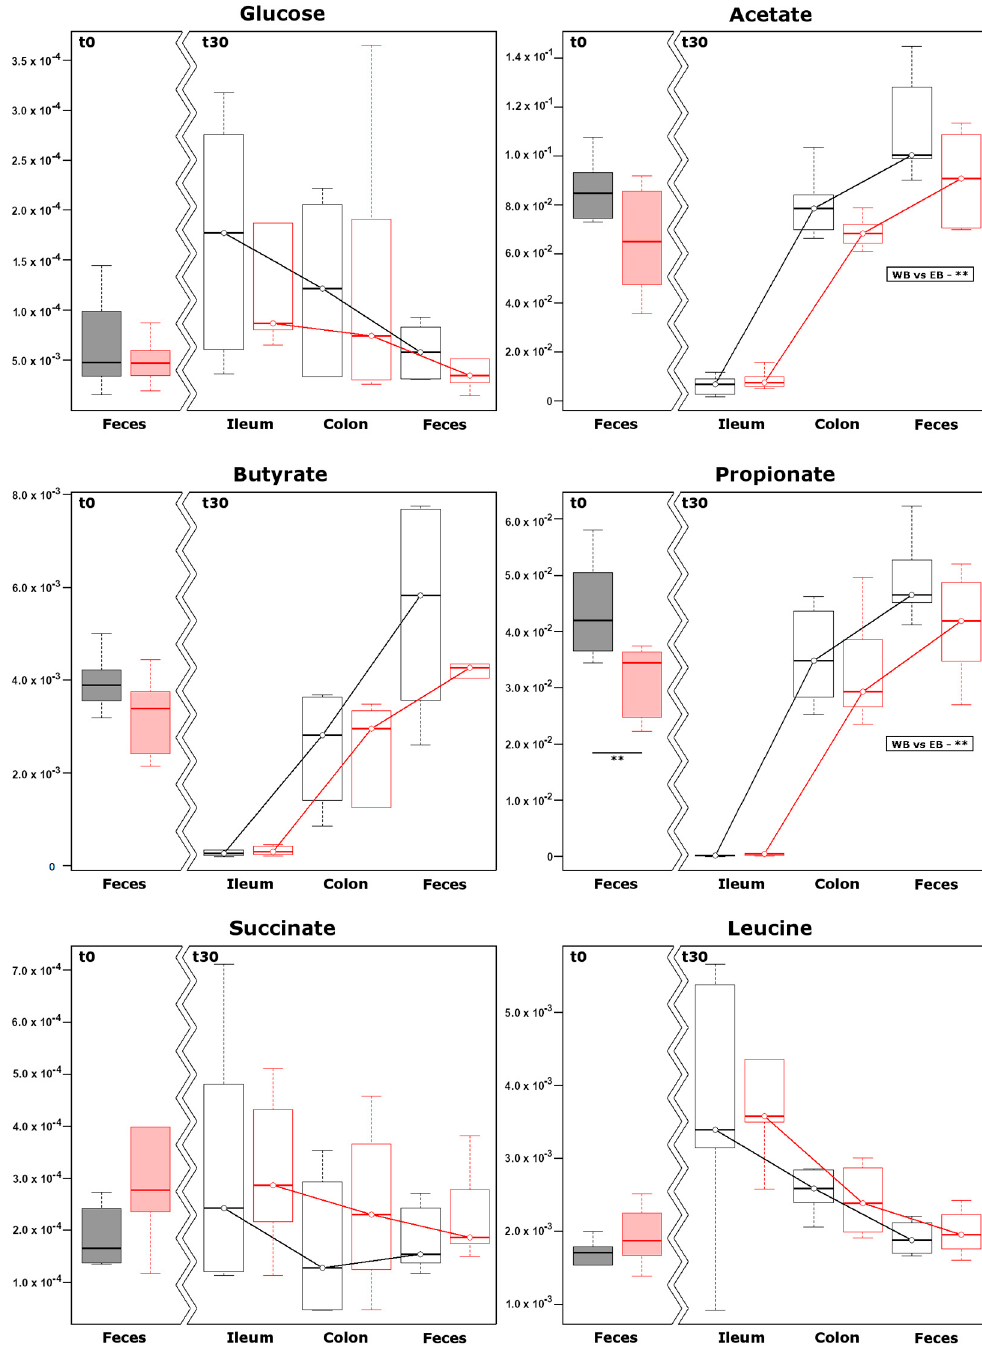
Figure 4. Concentration of glucose, short-chain fatty acids (SCFAs) (acetate, butyrate, and propionate), succinate and leucine along the pig intestine. Boxplots show, for wheat (black) and einkorn (red) bread-based diets, the concentration (mmol/L) of the metabolites in feces, at t0 and t30, and in ileum and colon contents, at t30. The inserts highlight the trends at t30 significantly affected by the diets, while significance of the differences at t0 or at t30 for feces are reported over the corresponding boxes. ** p value < 0 . 05.